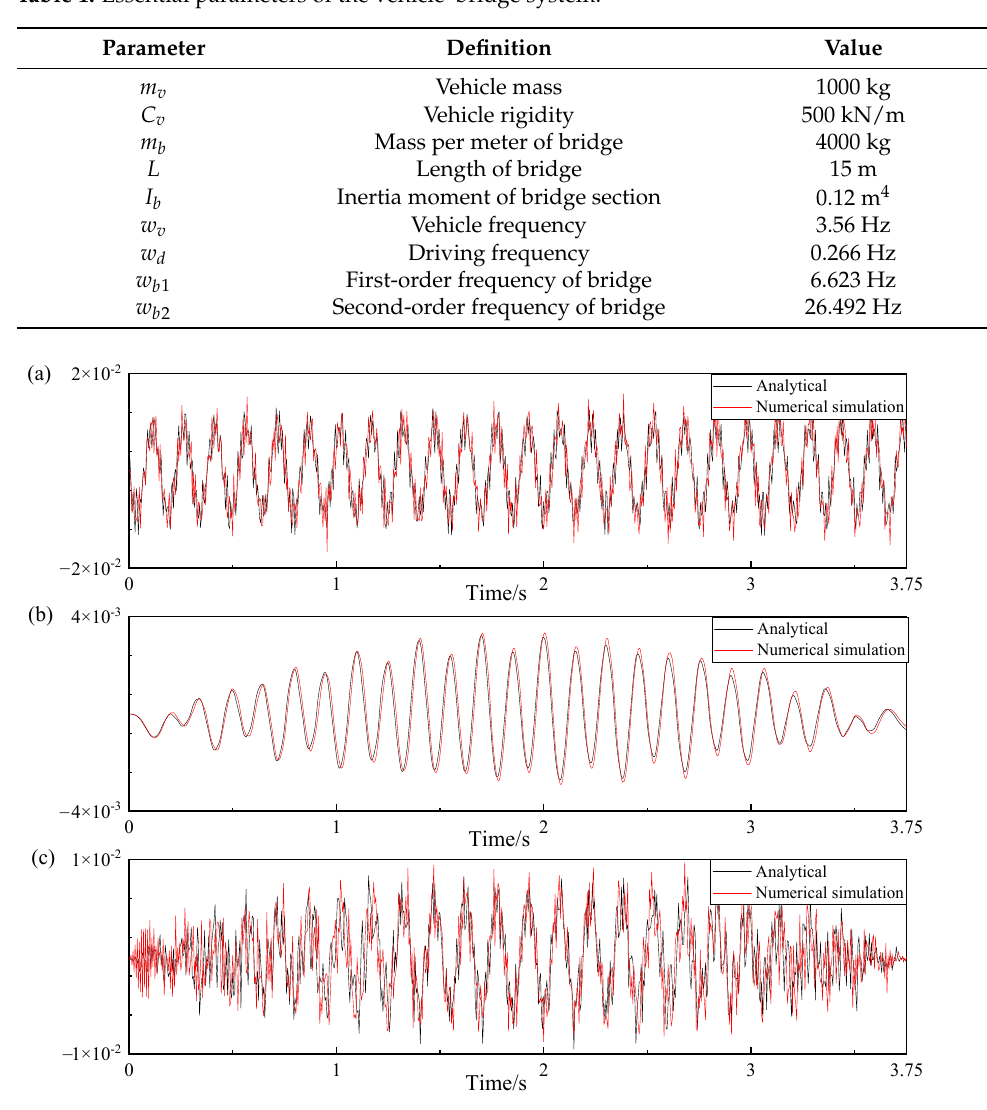
Figure 4. Comparison between the simulated dynamic response of the vehicle-bridge system and the analytical solutions: ( a ) bridge mid-span acceleration; ( b ) vehicle acceleration; ( c ) contact ‐ point acceleration.